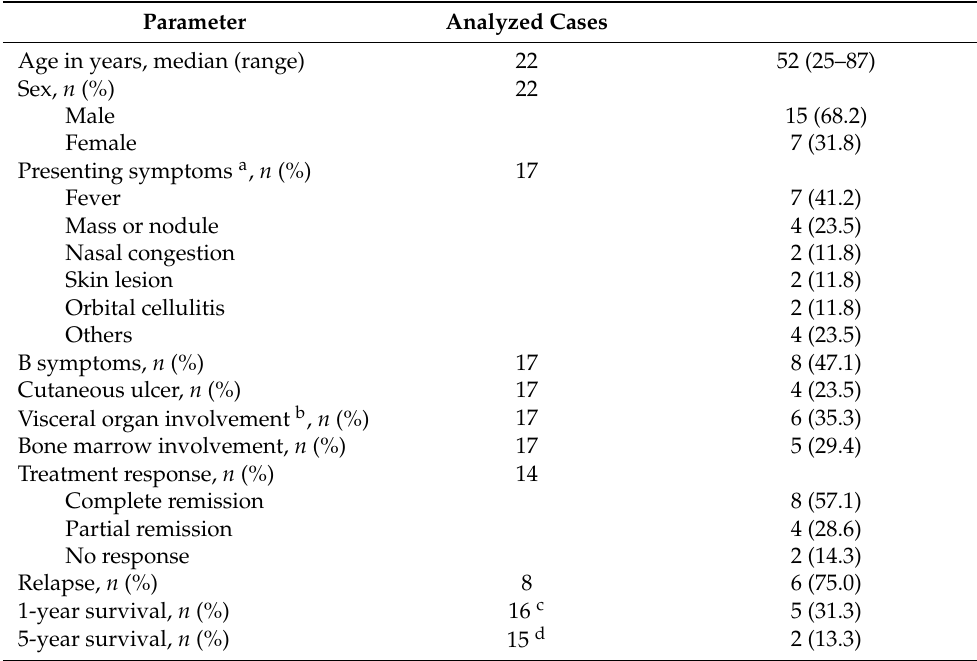
Table 1. Demographic data and clinical